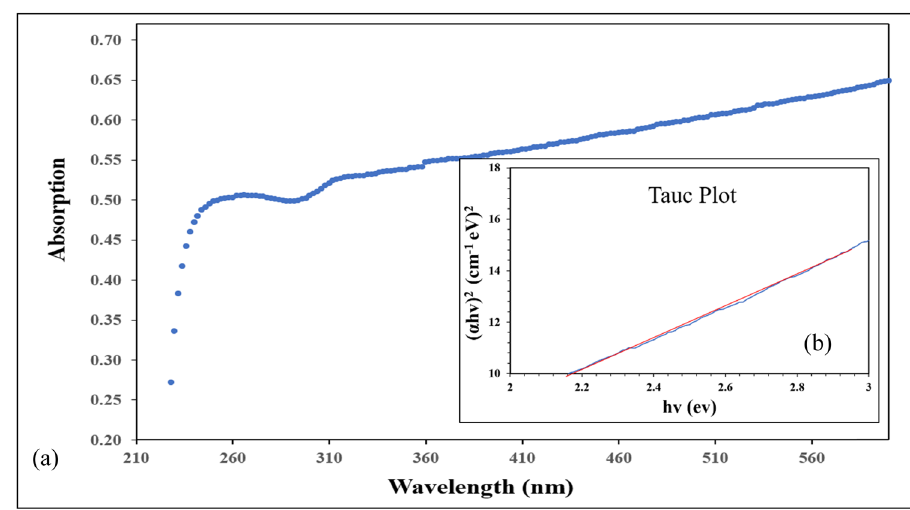
Figure 6: ( a ) UV - Vis Absorption spectra and ( b ) Tauc plot of